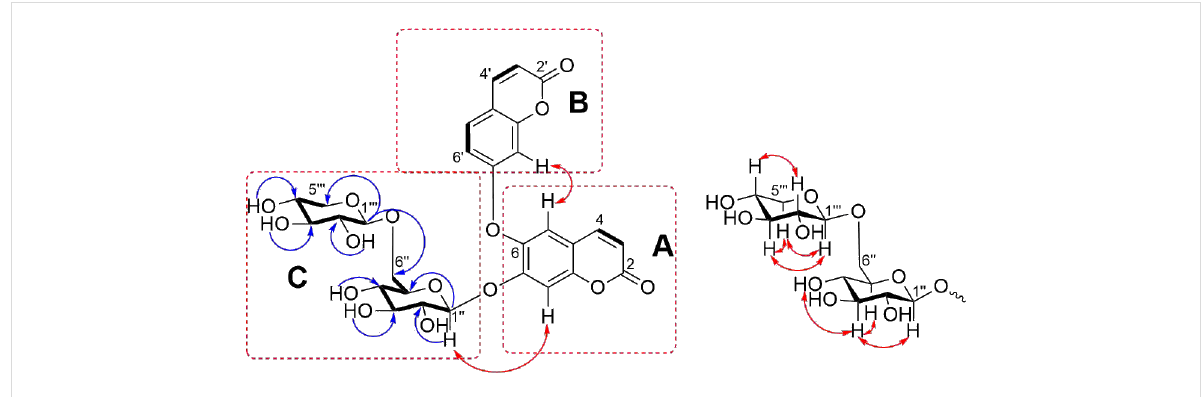
Figure 3: The key correlations observed in the 1 H- 1 H COSY (bold bonds), HMBC (blue), ROESY (red) of 1 (recorded in DMSO- d 6 , 800 MHz).